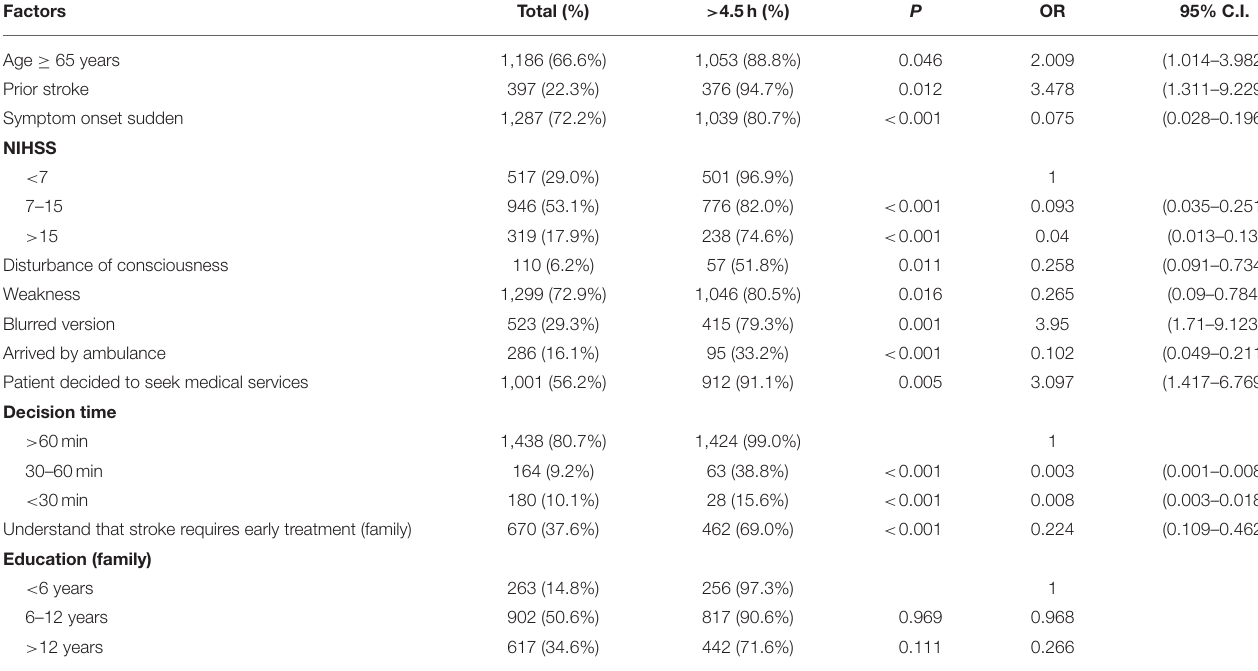
TABLE 1 | Logistic regression model of potential determinants for delay